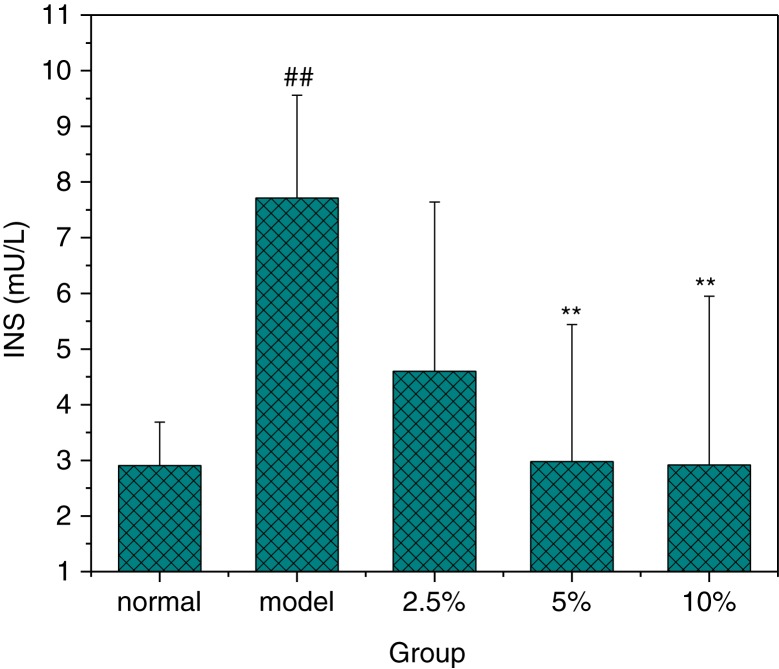
The effect of MBBP on insulin level after STZ injection. Data are mean ±SE values. ## Compared with the normal group with p<0.01, significant differences. ** Compared with the model group with p<0.01, significant differences. All data were obtained from groups of at least three mice.